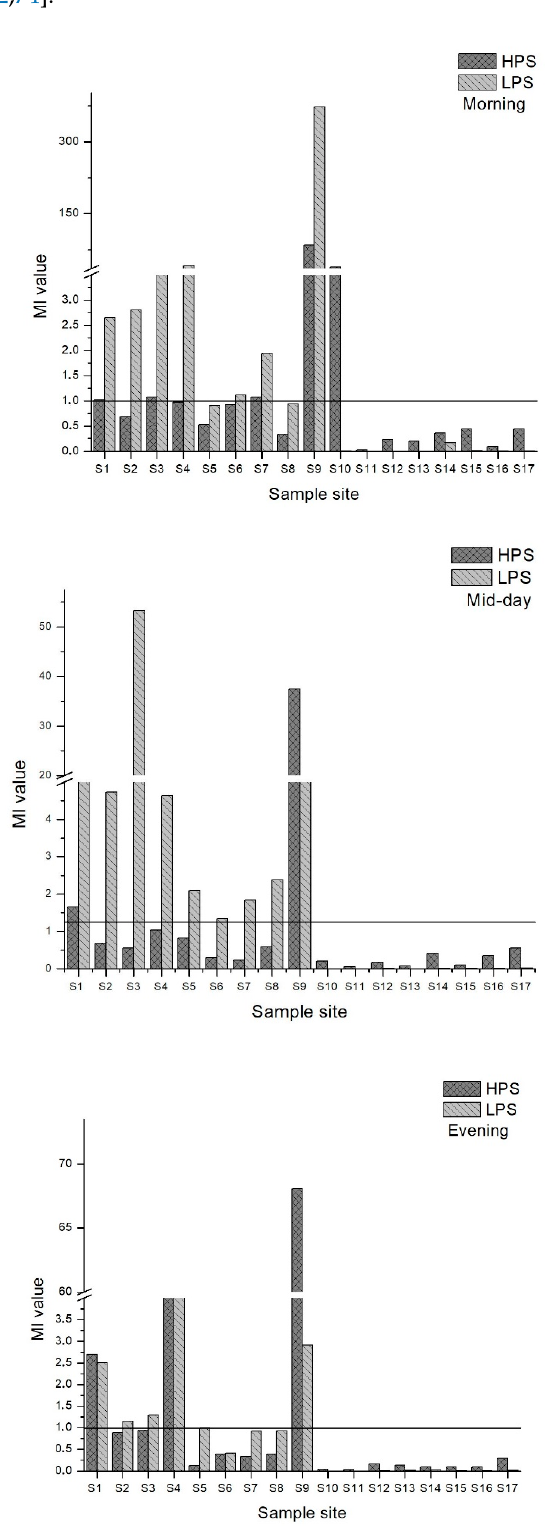
Figure 7. MI values for morning, midday and evening water samples for both